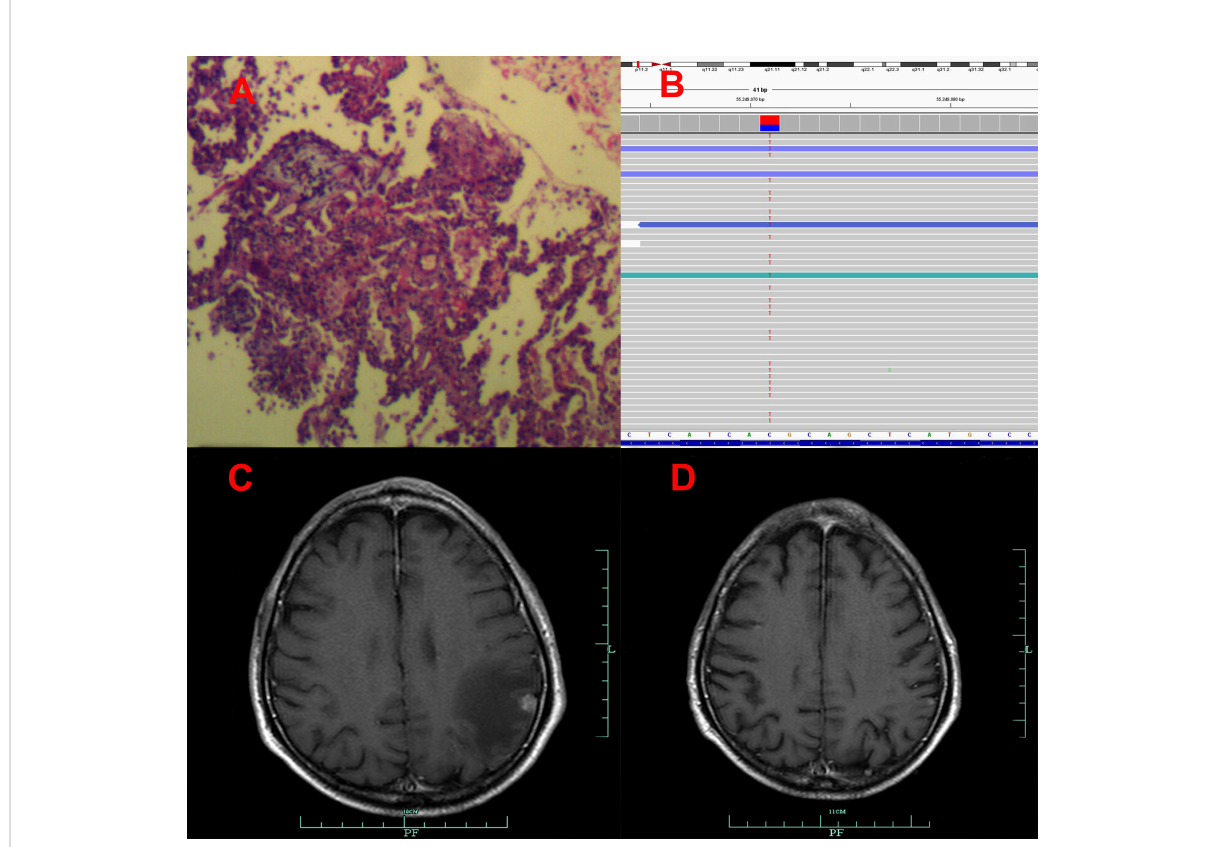
FIGURE 3 Pathological and clinical fi ndings of Patient 3. (A) Pathological fi ndings with HE staining. (B) NGS screenshots suggested increasing EGFR exon 20 T790M mutations (4% up to 87.5%). (C) Brain MRI image before salvage almonertinib treatment (after the emerging T790M mutation). (D) Brain MRI image after salvage osimertinib treatment (12).